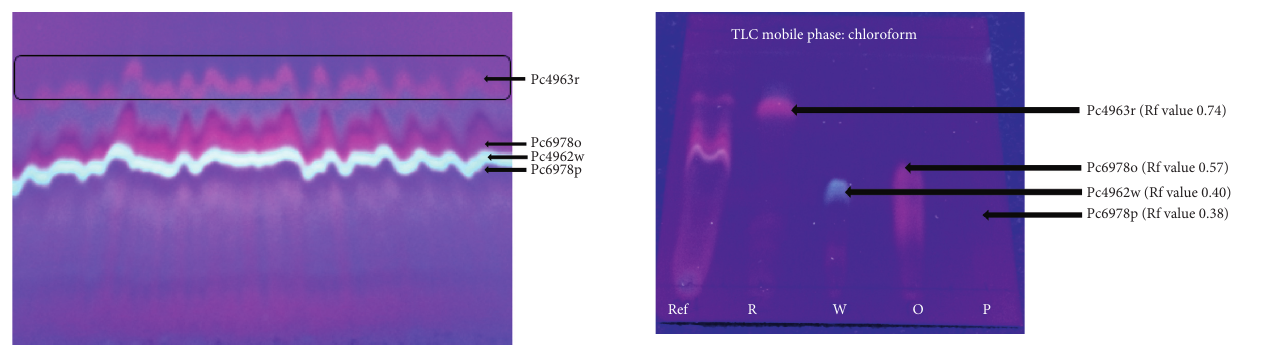
Figure 6: TLC plate showing the four isolated chromatograms as visualized under UV 254nm. Spot labeled R is the chromatogram Pc4963r. W is the chromatogram Pc4962w. Spot O is the chro- matogram Pc6978o. Spot labeled P is the chromatogram Pc6978p. Spot labeled Rf represents unpurified pools as a reference. Chlo- roform was the mobile